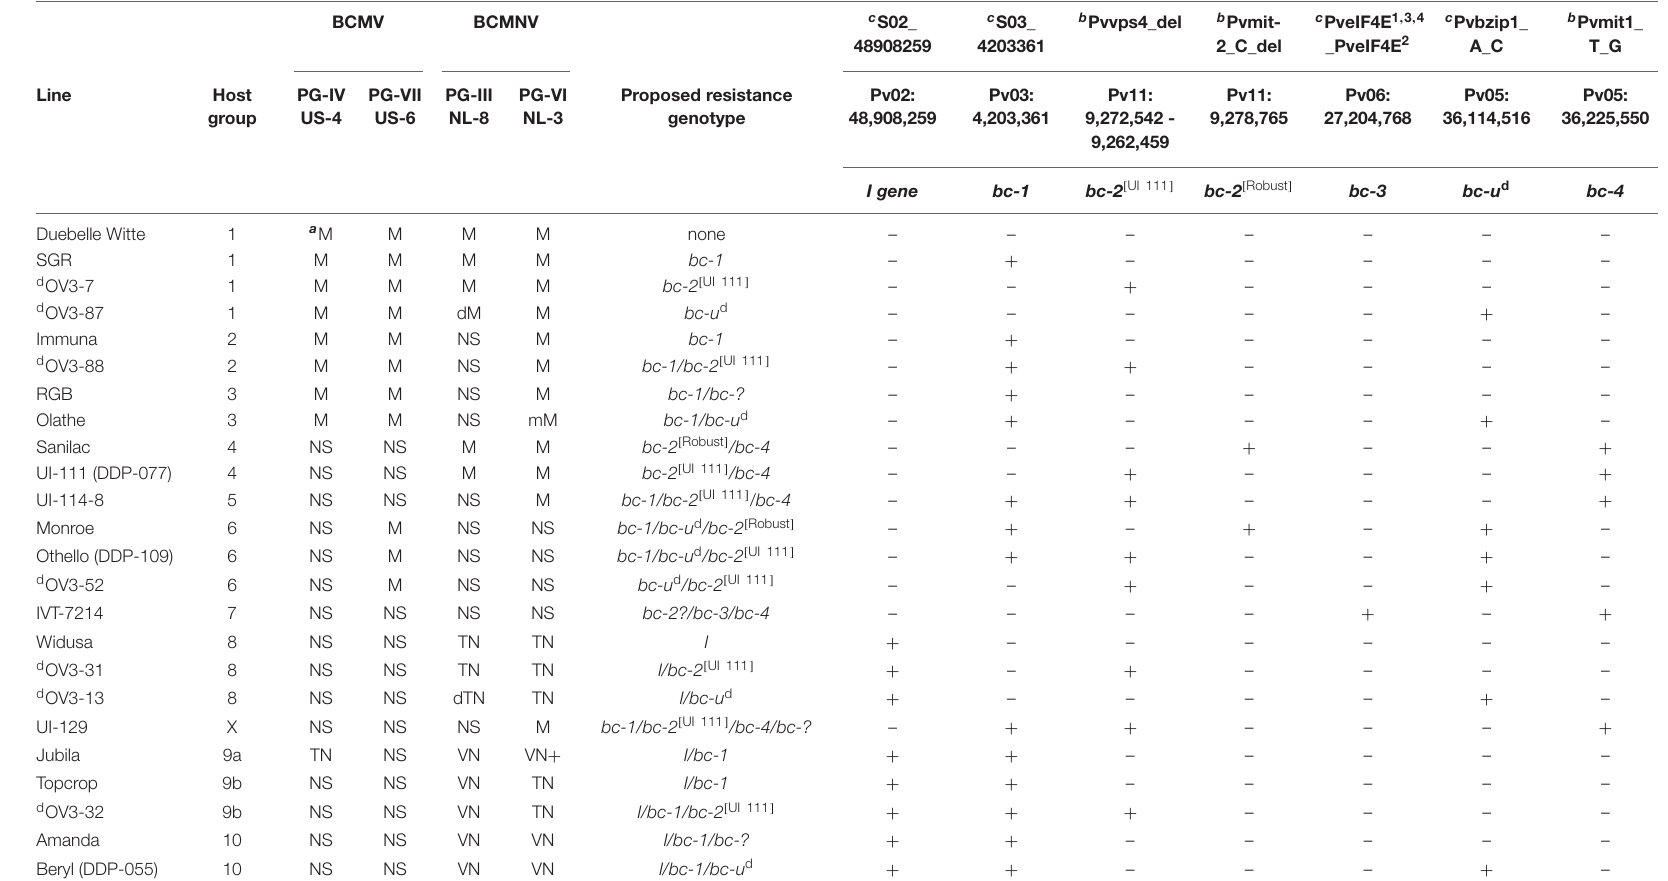
TABLE 3 | Single-nucleotide polymorphism (SNP) genotyping of host differential genotypes, including OV RILs with new unrepresented genotypes within specific host groups, with reactions to select Bean common mosaic virus (BCMV) and Bean common mosaic necrosis virus (BCMNV) strains.